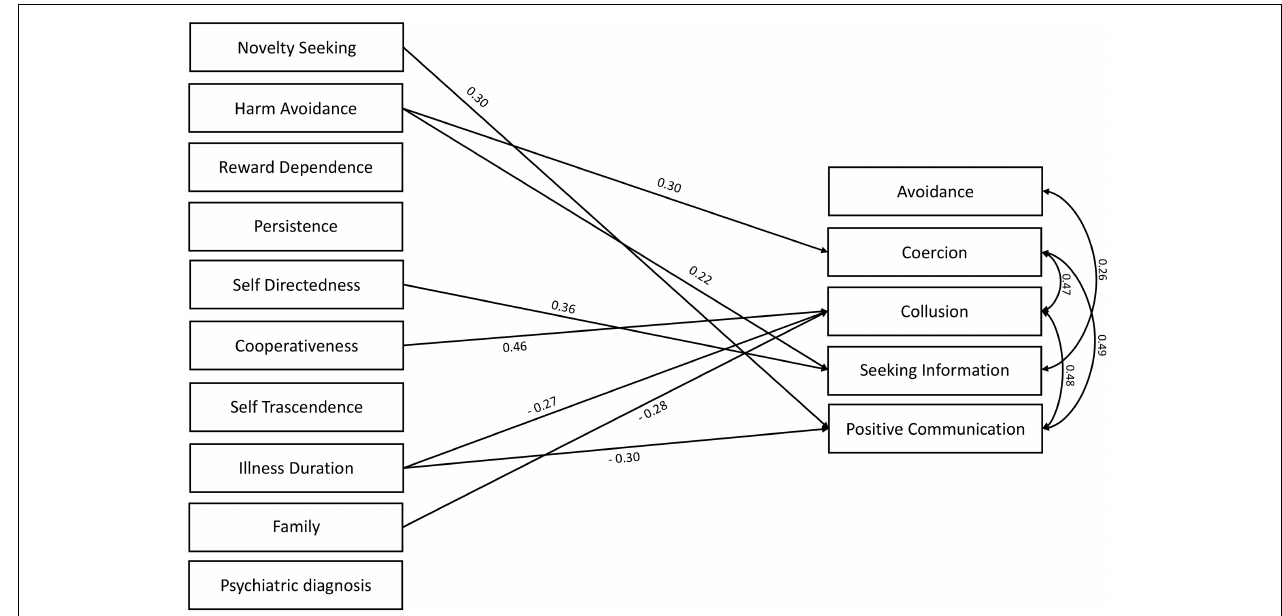
FIGURE 1 | Multivariate regression analyses in the sample of fathers. Standardized beta is reported on the arrows (df =